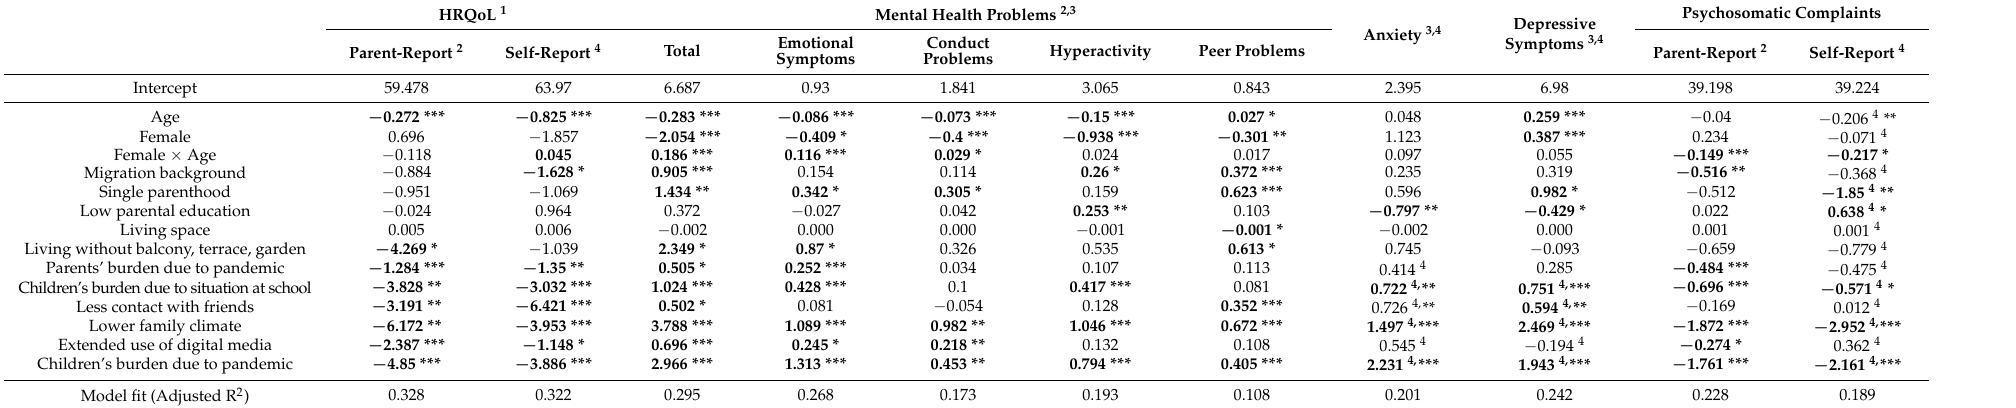
The table indicates regression coefficients for all independent variables, controlling for the other predictors. * p < 0.05, ** p < 0.01, *** p < 0.005. 1 Higher value indicates better quality. 2 Parent-report 7–19 years. 3 Higher value indicates stronger symptoms and complaints. 4 Self-report 11–19